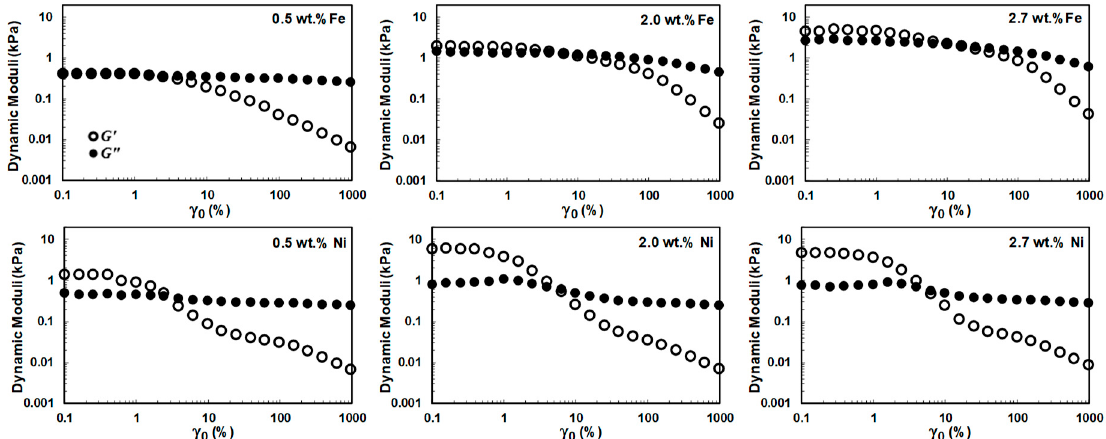
Figure 4. Oscillatory amplitude sweep response of neat PVDF and CNT/PVDF nanocomposites containing 0.5, 2.0, and 2.7 wt.% of carbon nanotubes synthesized on different catalysts for strain amplitudes of γ 0 = 0.1–1000% at an angular frequency of ω = 0.1 rad/s using cone-plate geometry (truncation of 47 μ m) at 240 °C.